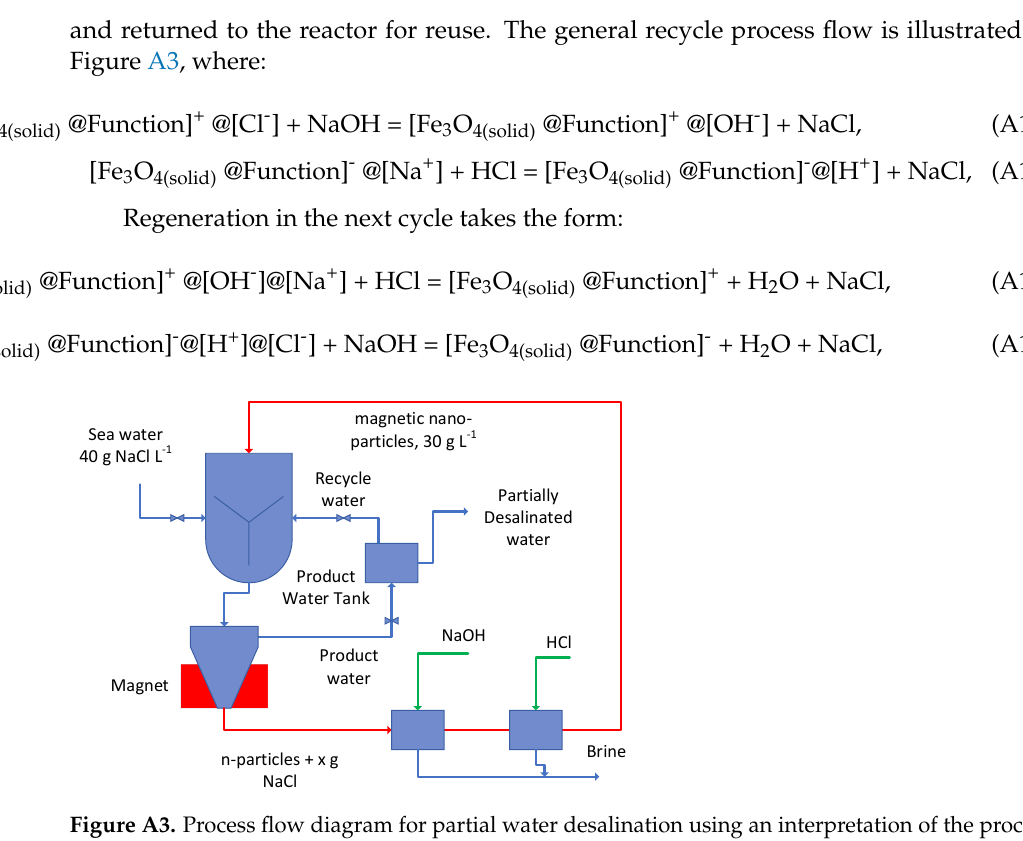
Figure A3. Process flow diagram for partial water desalination using an interpretation of the process described in patent US8636906B2, using seawater or saline groundwater feed to produce partially desalinated irrigation water.